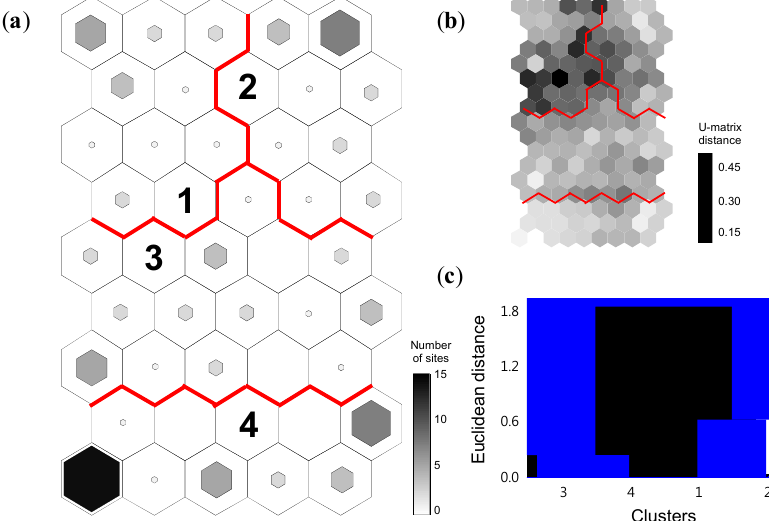
Figure 5. ( a ) Classification of samples based on nine heavy metals released into freshwater ecosystems in Korea from 1999 to 2010 through the training of self-organizing map (SOM), ( b ) U-matrix, and ( c ) dendrogram of the hierarchical cluster analysis with the Ward linkage method using Euclidean distance for the SOM